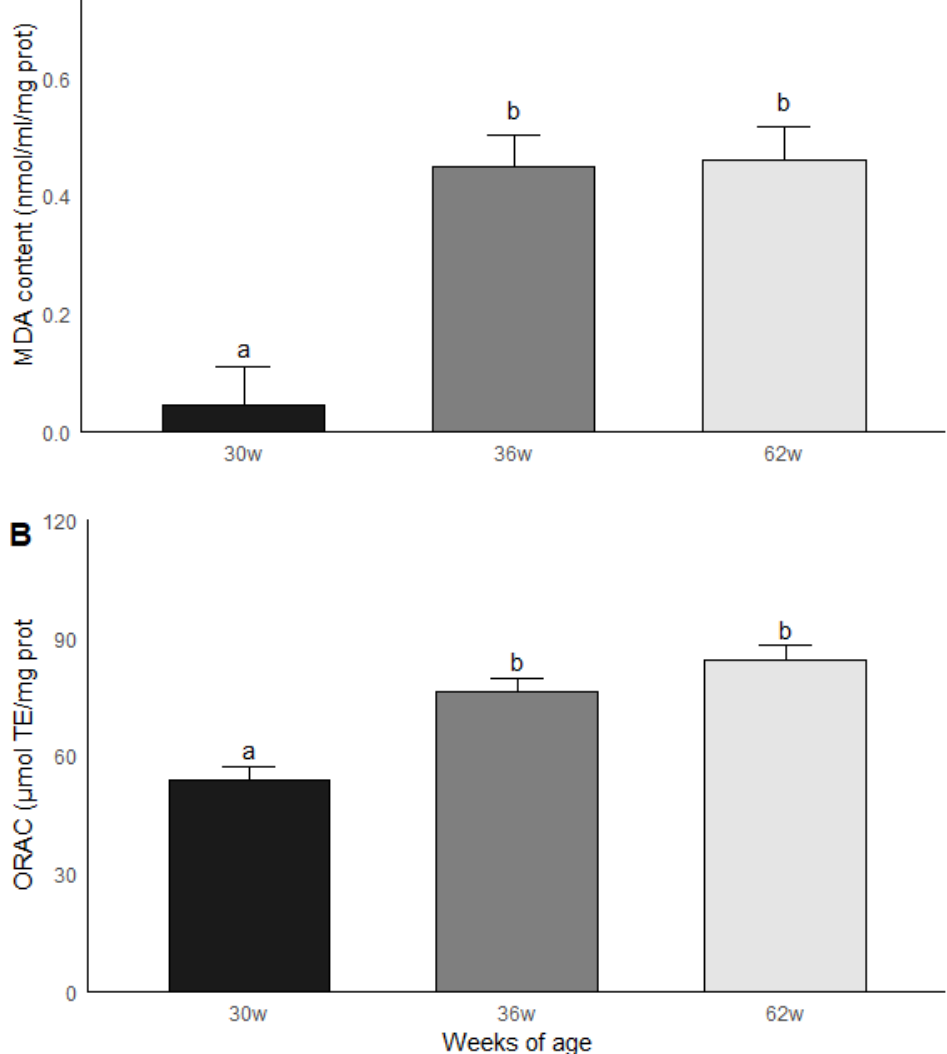
Figure 4. Malondialdehyde (MDA) ( A ) content and ( B ) non-enzymatic antioxidant capacity (ORAC) in testicular parenchima of roosters of 30, 36 and 62 weeks of age. Data are mean ± SEM of measurements by duplicate. The roosters of 30 weeks of age had a lower MDA content compared to the roosters of 36 and 62 weeks of age, while